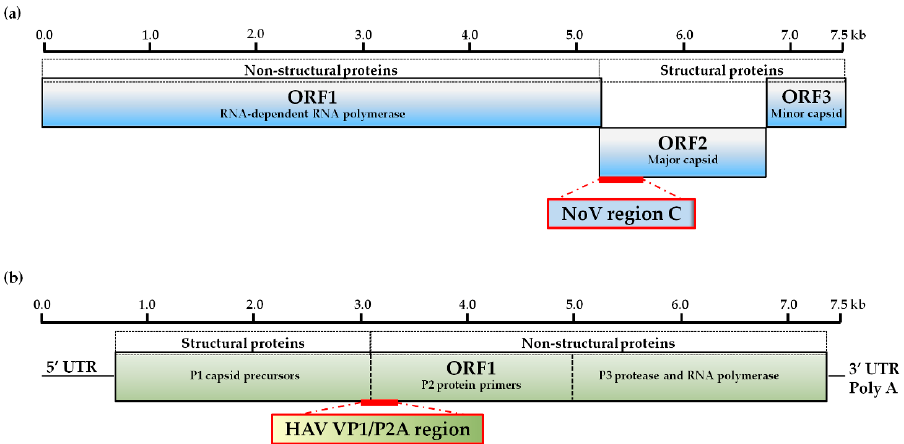
Figure 1. Schematic diagram of the genomic regions in ( a ) NoV and ( b ) HAV targeted by the capture probes in the array-based typing assay.